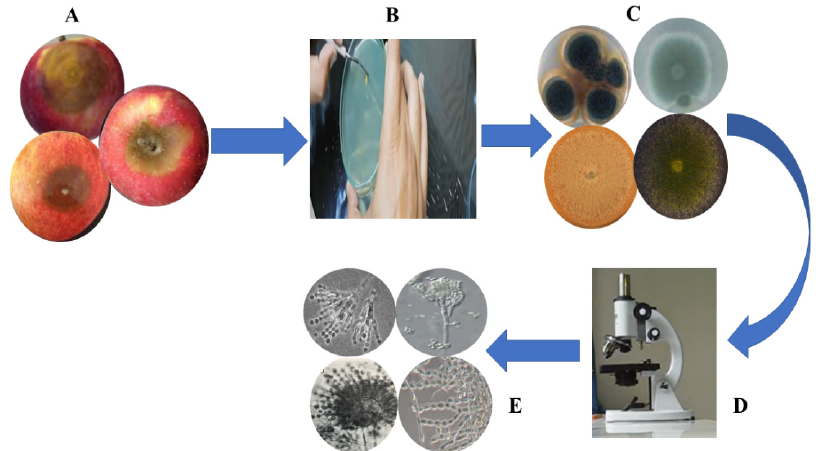
Figure 6. (A ) Spoilt apple fruits, ( B ) culture on PDA media, ( C ) growth of fungus on PDA media, ( D ) microscope, and ( E ) microscopic identification of fungus. ( D ) microscope, and ( E ) microscopic identification of